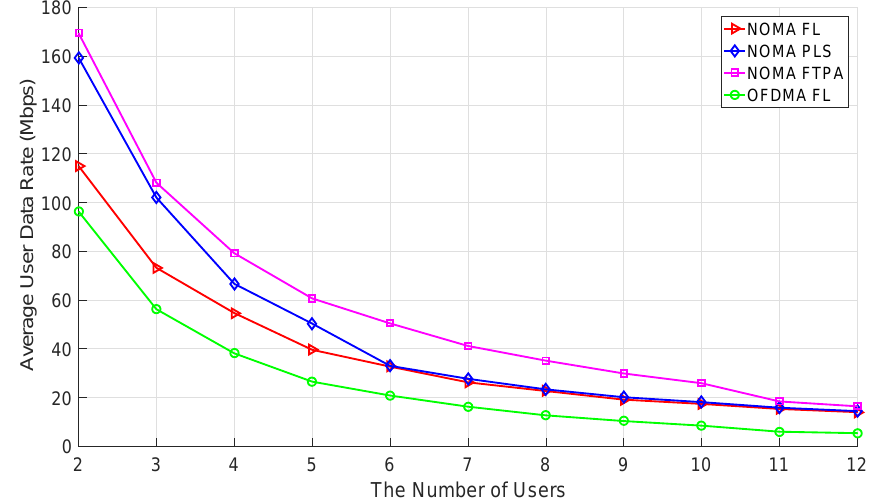
Figure 3. Comparisons of the average user data rate (AUDR) in two dimensions without quality-of-service (QoS) features. The labels FL, FTPA, NOMA, OFDMA, and PLS are fuzzy logic, fractional transmit power allocation, non-orthogonal multiple access, orthogonal frequency division multiple access, and power law strategy, respectively.